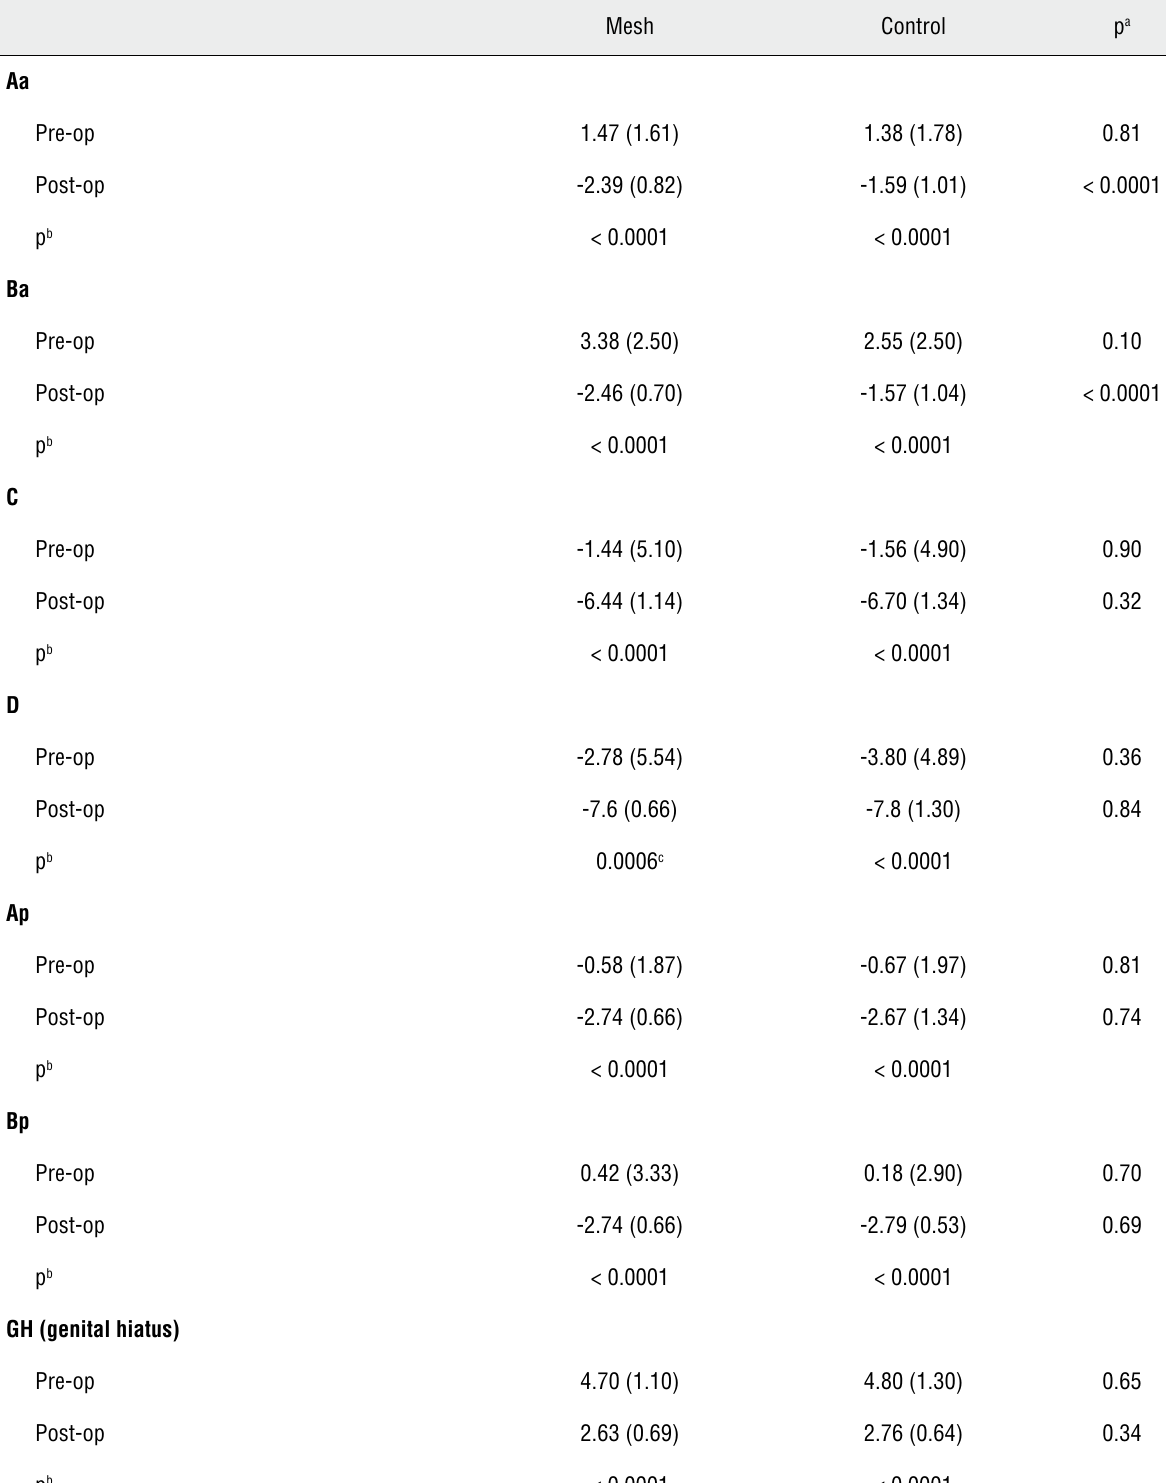
Mesh Control p a